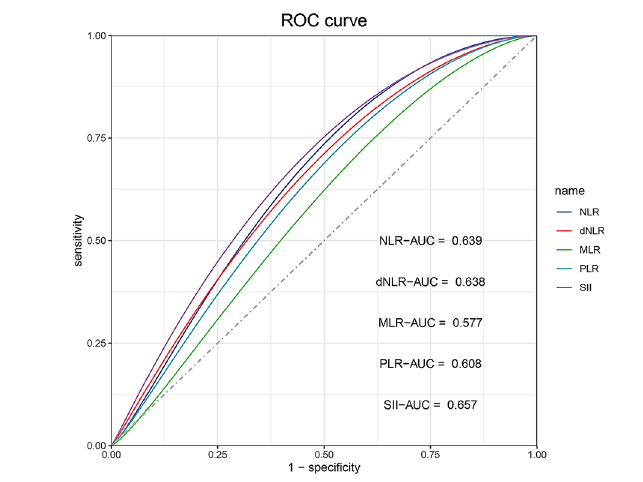
second line or posterior, and lymph node metastasis; otherwise, a score of 0 was given. We divided patients into three subgroups based on their scores: low-risk group (score of 0), middle-risk group (score of 1 or 2), and high-risk group (score of 3 or 4). Among the